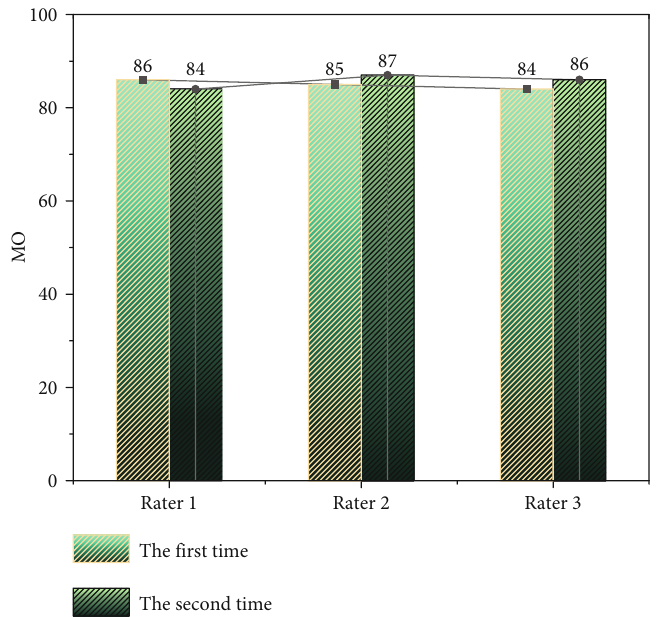
Figure 2: Composite MQ interrater reliability and intrarater reliability.